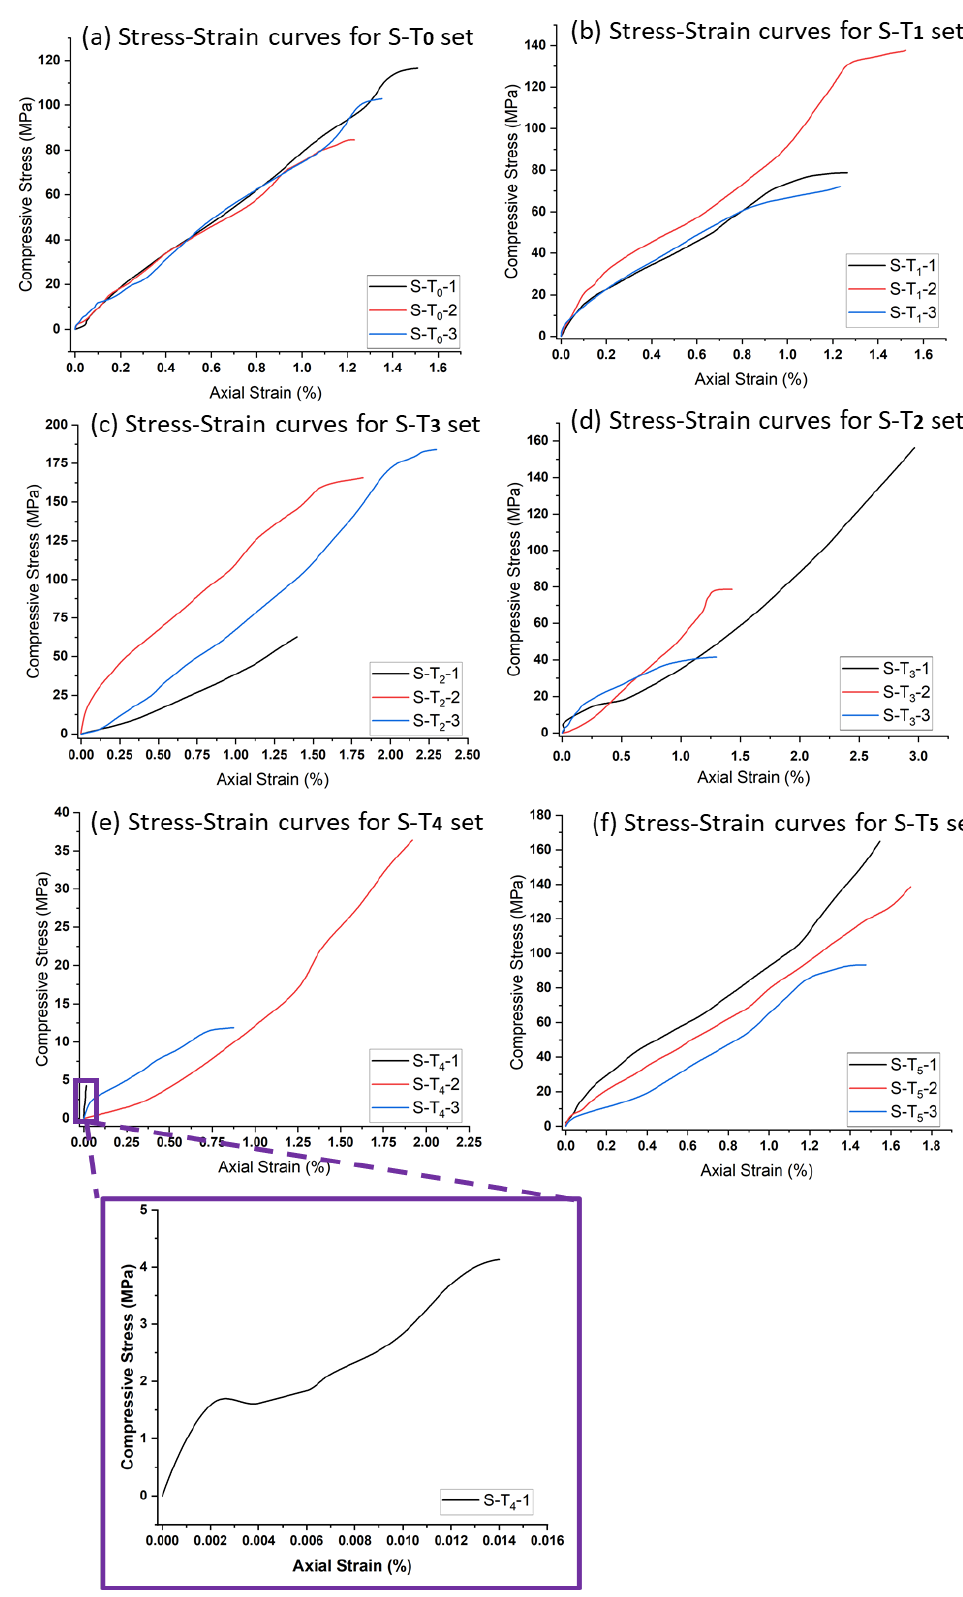
Figure 16. The stress–strain curves of the investigated samples at different temperatures: ( a ) speci- mens at 22 °C, ( b ) specimens at 200 °C, ( c ) specimens at 400 °C, ( d ) specimens at 600 °C, ( e ) specimens at 800 °C, and ( f ) specimens at 500 °C.